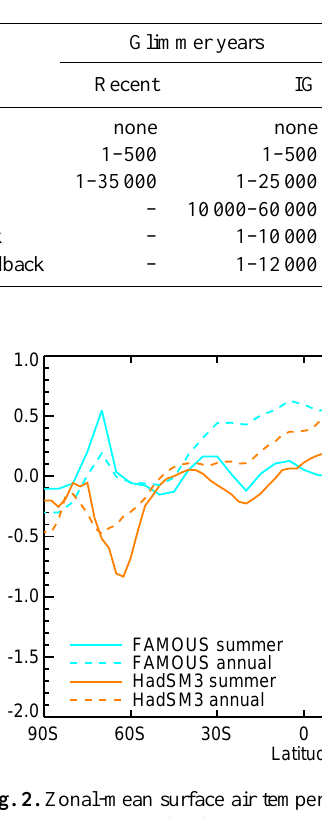
Table 1. List of FAMOUS experiments discussed in this work. The notation 1 : n indicates an asychronous integration with n Glimmer ice- sheet years for each FAMOUS climate year; in this notation, the synchronous integrations are 1 : 1. “Recent” and “IG” (“incipient glacial”) identify the climate conditions, and for each FAMOUS–Glimmer experiment the range of Glimmer years is shown. The two FAMOUS-only experiments were 400yr long, preceded by 300yr of spin-up.